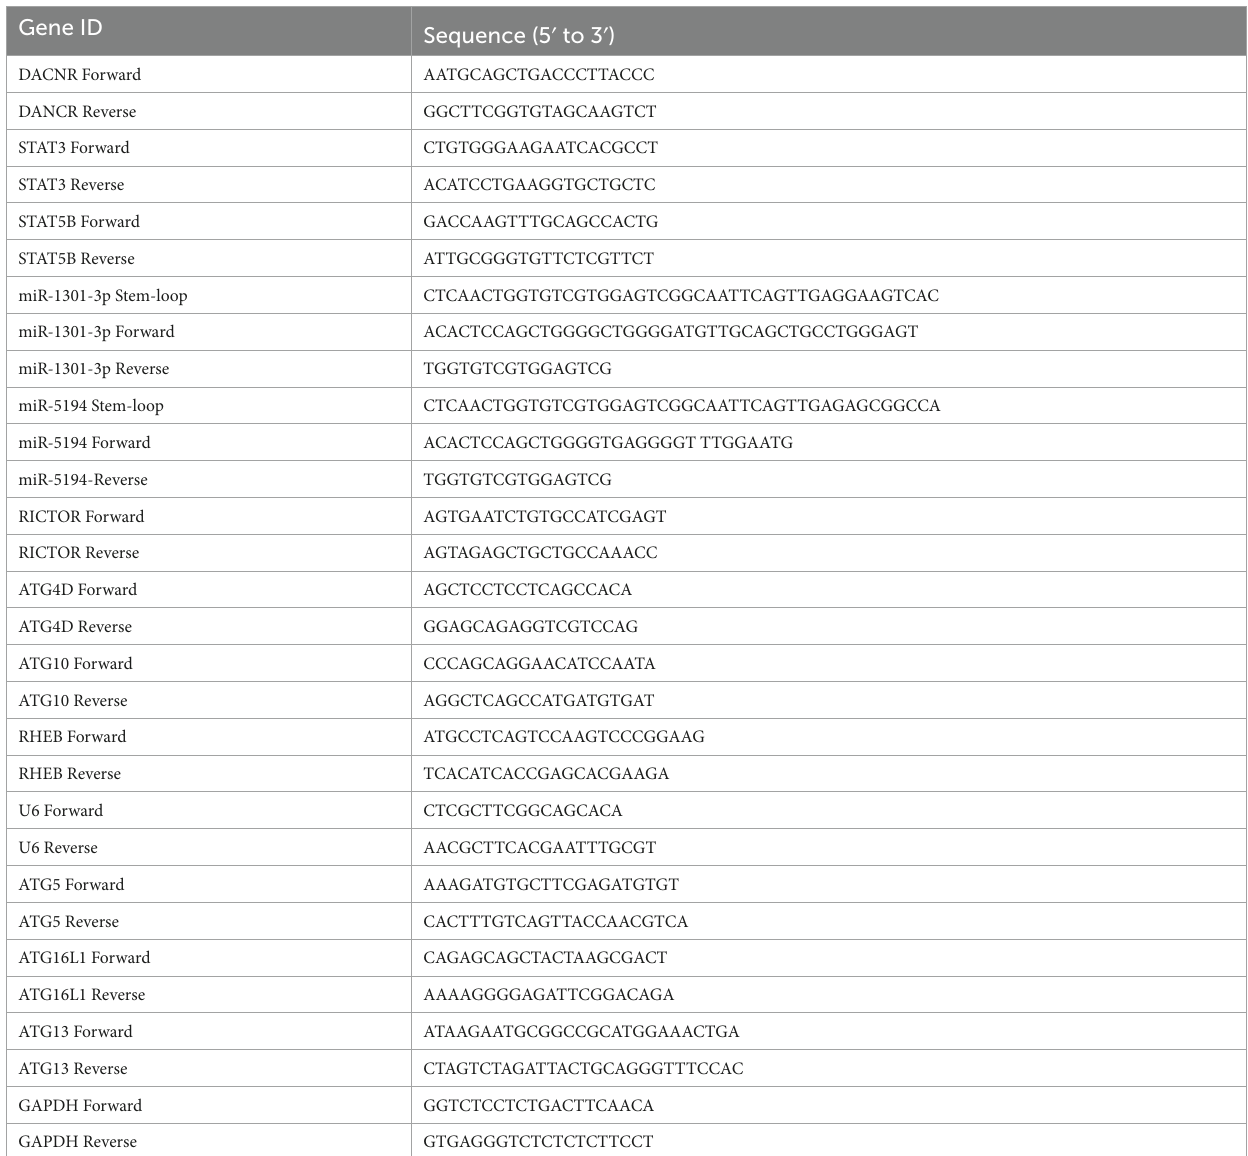
TABLE 1 Primer details of